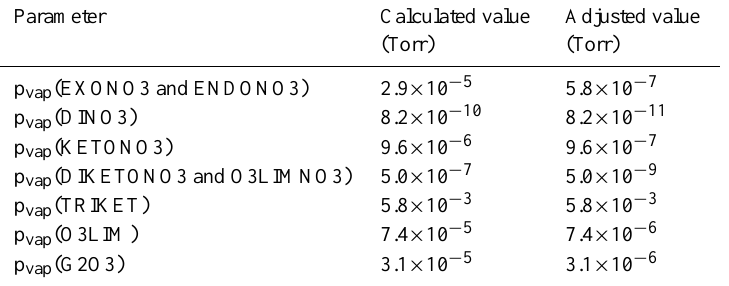
Table 3. Parameters used in gas-aerosol partitioning portion of the kinetics box model. Calculated vapor pressures were determined using the formalism of Pankow and Asher (2008). For reference, the p vap determined for a pinene monohydroxynitrate was 4 . 0 × 10 − 5 Torr (Fry et al., 2009).